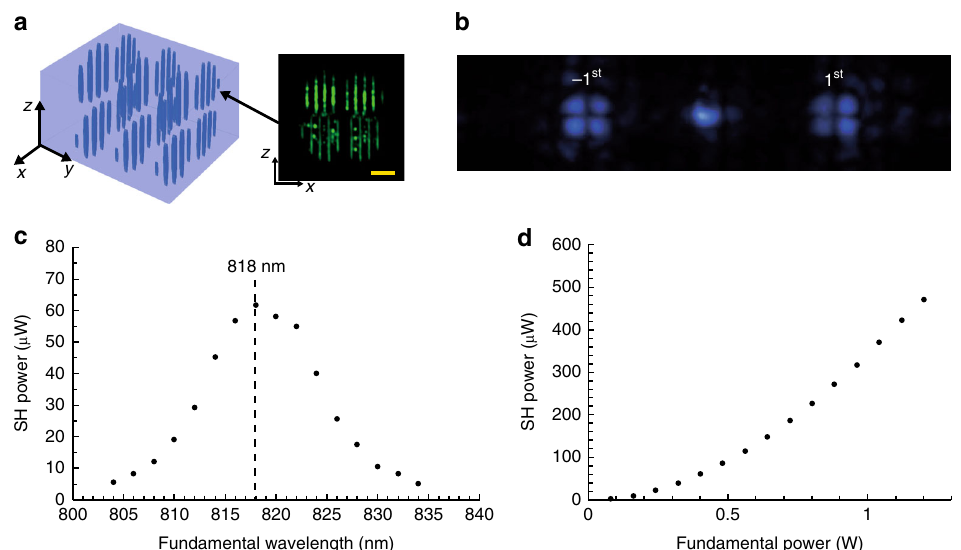
Fig. 4 Ef fi cient SH HG beam generation. a The 3D NPC model and the confocal SH image of its cross-section in the x – z plane (the length of scale bar, 10 μ m). b The SH diffraction pattern pumped under the QPM wavelength of 818 nm. c Dependence of output power of the 1 st diffraction order on the fundamental wavelength at a pump power of 0.4 W. d Dependence of output power of the SH HG beam on pump power at the wavelength of 818 nm. The maximal conversion ef fi ciency reaches to ~3.9 × 10 − 4 for the 1st diffraction